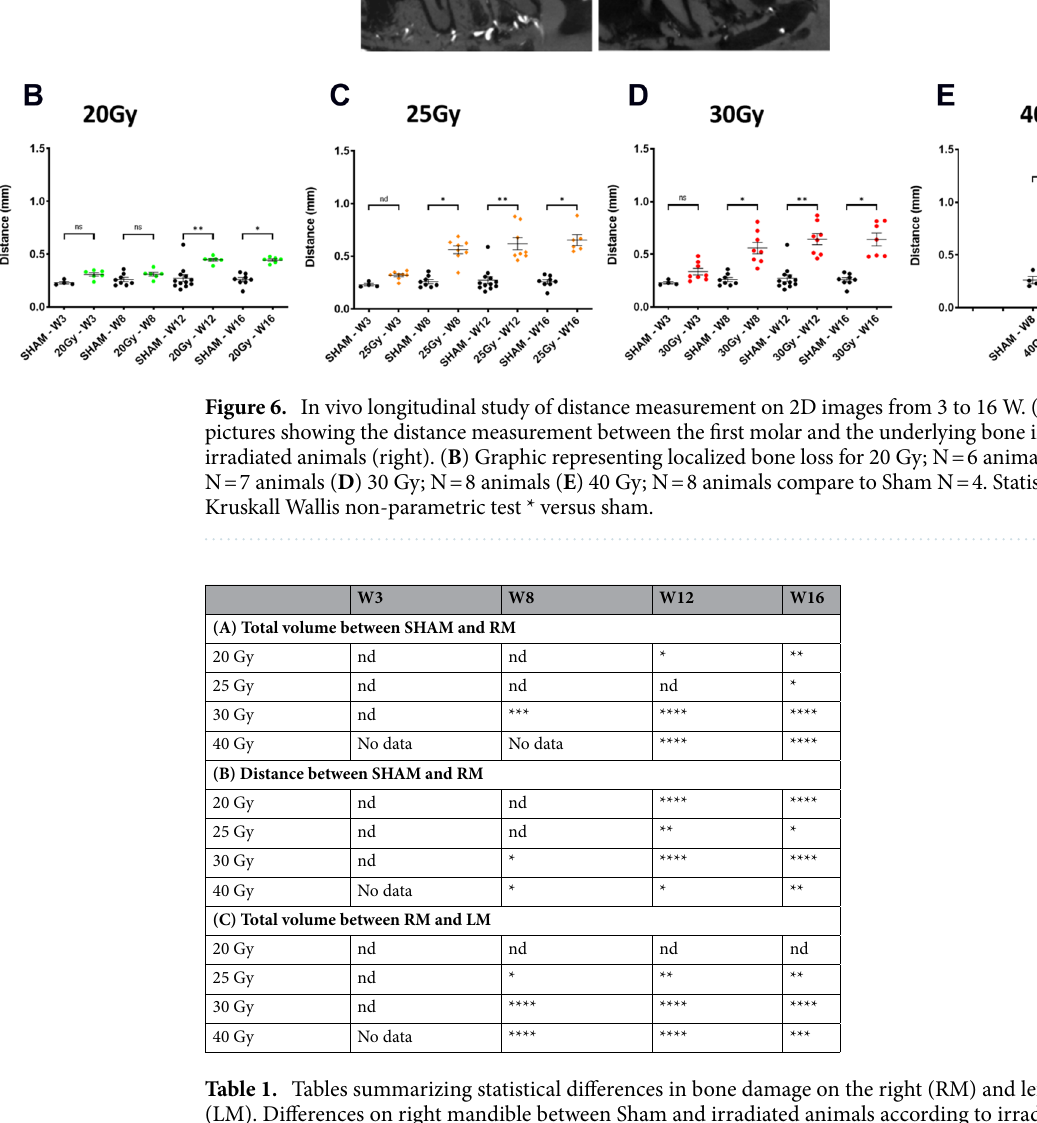
a statistical bone defect on the right mandible for 25 Gy only at the latest time point (16 W) (Table 1A). We observed that 2D distance measurement on the right mandible reflects statistical differences with the sham group for 20 Gy and 25 Gy at 12 W and for 30 and 40 Gy statistical differences with the sham group are detected as 8 W (Table 1B). These results confirm the high sensitivity of 2D distance measurements for minor injuries. Our irradiation model induces bone defects on the right mandible even if no teeth are extracted. However, total bone damage is less pronounced on the right mandible than the left mandible (Table 1C). Total bone volume measurements demonstrated statistical differences between the left and right mandibles from 25 Gy irradiation dose and after 8 W of irradiation.